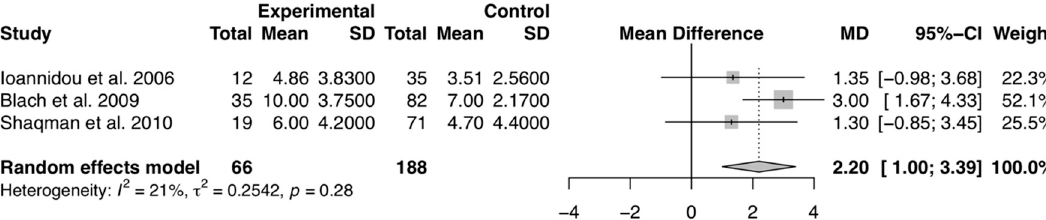
Figure 3. Forest plot of studies with serum IL-6 mean values comparing transplanted patients with and without periodontitis. Mean effect size estimates have been calculated with 95% confidence intervals and are shown in the figure. Area of squares represents sample size, continuous horizontal lines and diamonds width represents 95% confidence interval. The bottom diamond center and the vertical dotted line represent the overall pooled estimate.